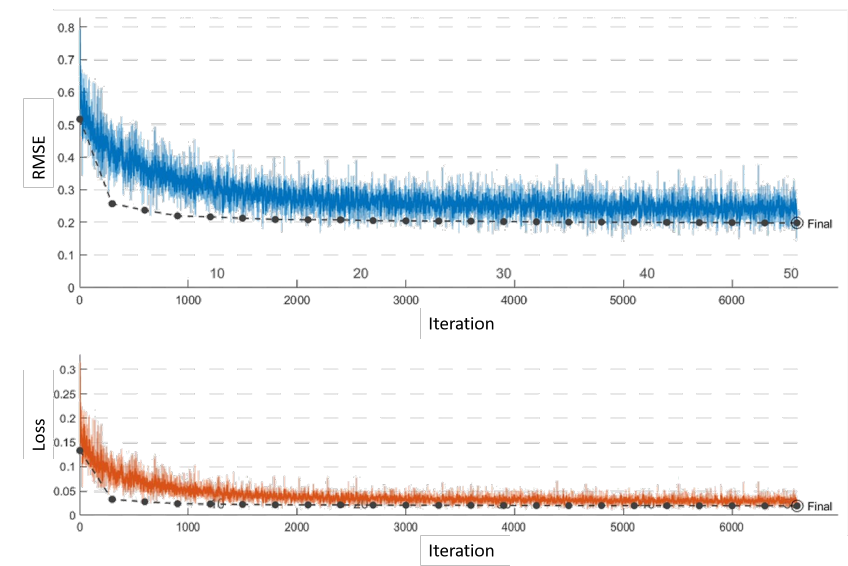
Figure 11. Proposed network: configured with a learning rate of 10 − 1 , piece-wise scheduling, and 50 Epochs. Completed 50 Epochs in 23% of the VGG-19’s time and final RMSE of 0.19.